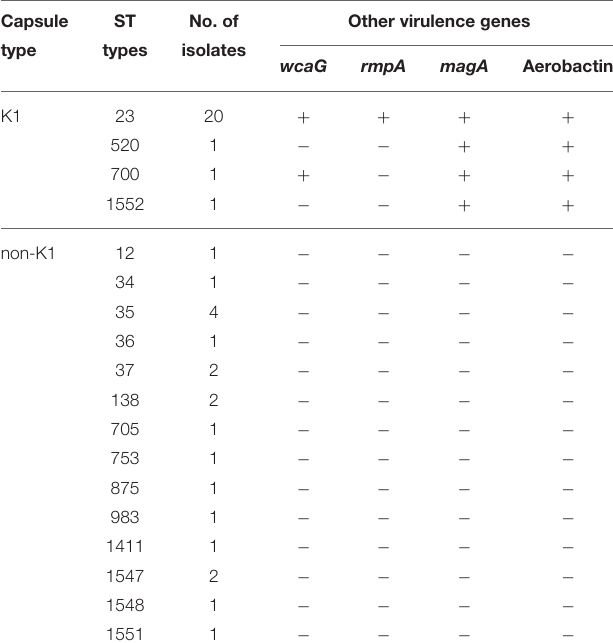
TABLE 2 | Prevalence of ST types and known virulence genes in K1 hvKP and non-K1 K. pneumoniae